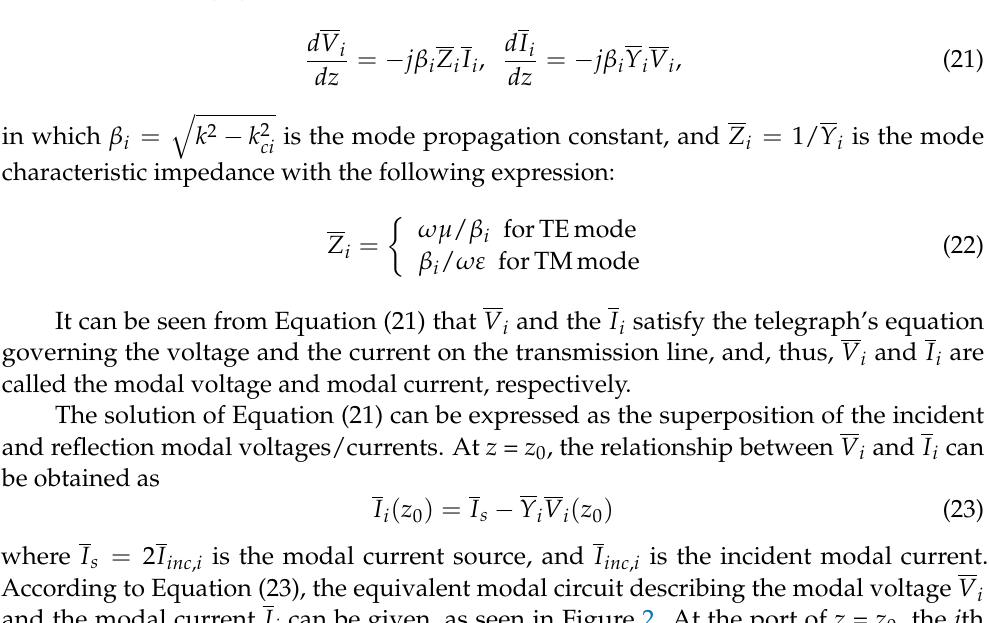
Figure 1. A uniform WLTL: ( a ) cross-section view and ( b ) longitudinal view.